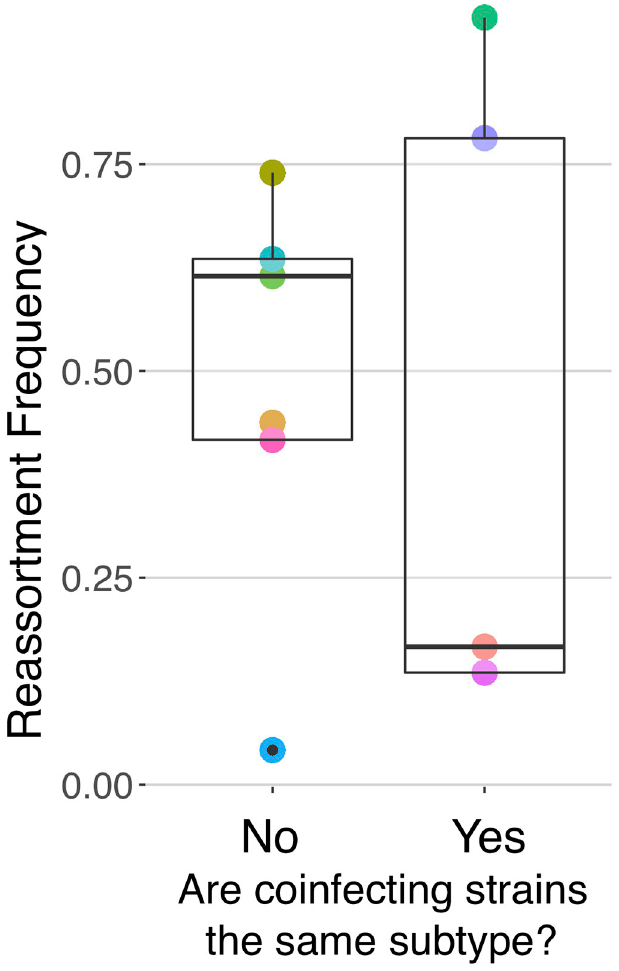
Fig 4. There is no significant difference in reassortment frequencies in intrasubtype (H1N1 or H3N2) coinfections versus intersubtype coinfections (H1N1xH3N2).